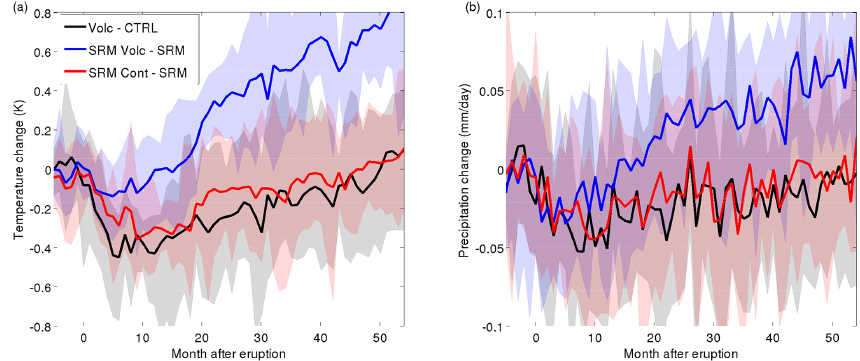
Figure 4. Global mean 2m (a) temperature and (b) precipitation changes after the volcanic eruption compared to the background condition (black line) and during solar radiation management (blue and red lines). Solid lines are mean values of the ten members of the ensemble simulations. The maximum and minimum values of the ensemble are depicted by shaded